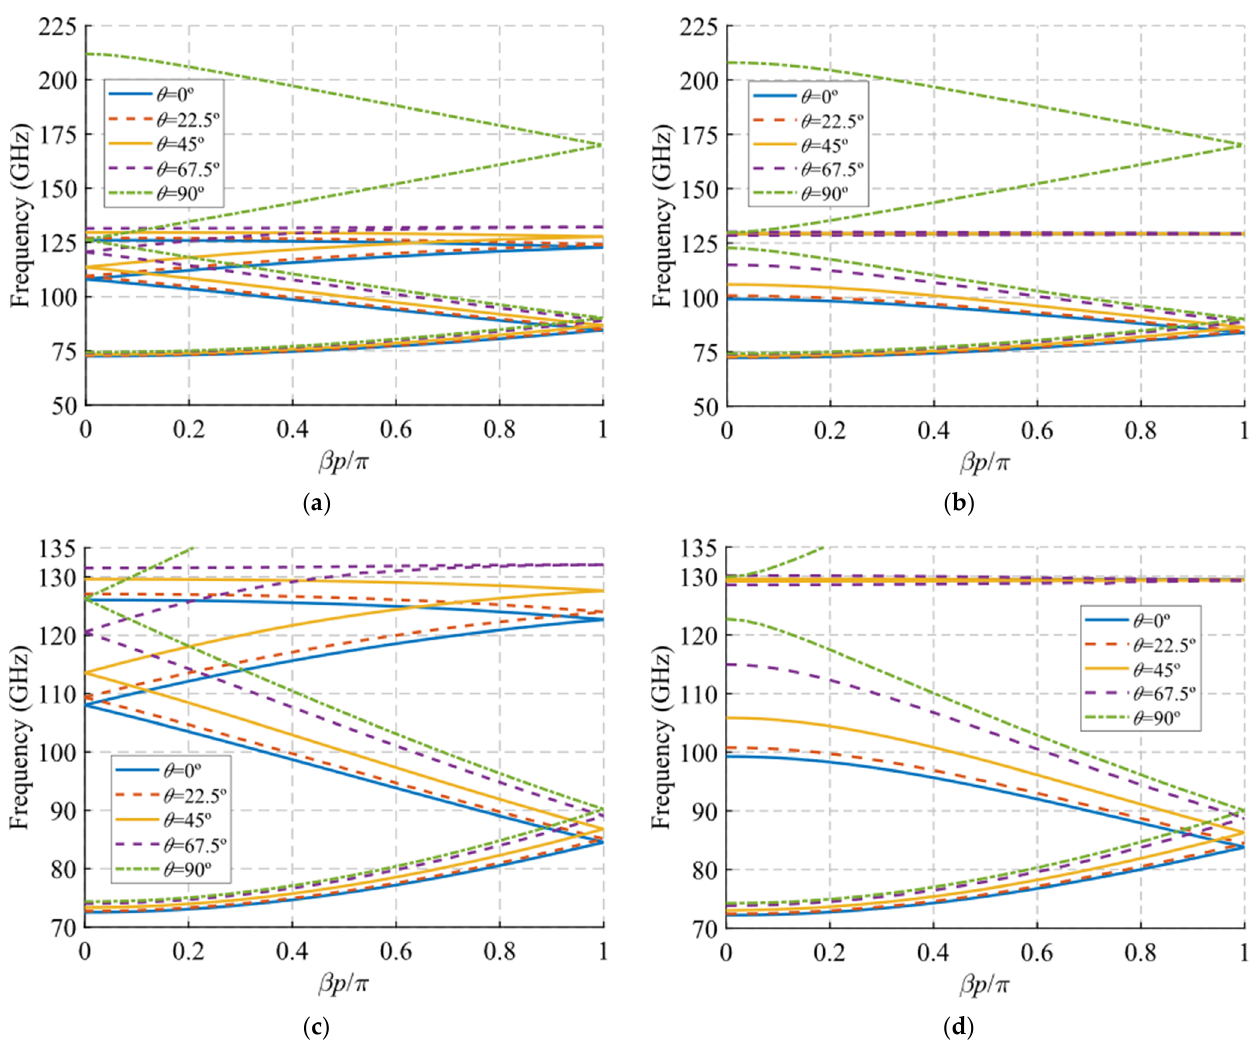
Figure 10. Dispersion diagram of the double-periodic unit cell for various values of p . ( a ) Glide- symmetric configuration ( d = 0.725 mm) and ( b ) maximum rupture of symmetry configuration ( d = 0 mm).